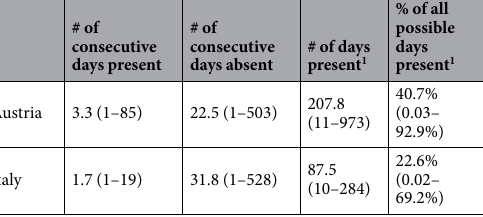
Table 1. To illustrate the individual variation we calculated for the Austrian and Italian study site mean, minimum and maximum values over all individuals for: the number of consecutive days being present or absent, the total number of days present and the percentage of days present (data refer to the time between marking and their last observation). 1 Only individuals with at least 10 observations were included; N = 126 for AUT and N = 52 for